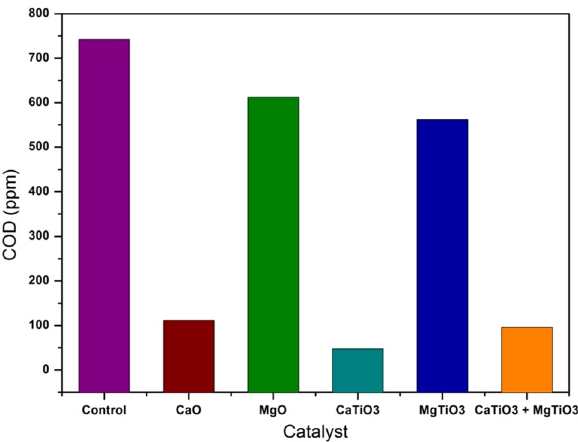
Figure 8. COD of degraded RhB dye with calcium/magnesium oxides and titanates catalyst under UV